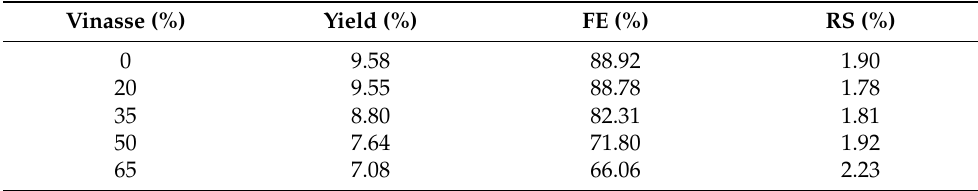
Table 1. Effect of vinasse concentration on yield, FE, and RS.